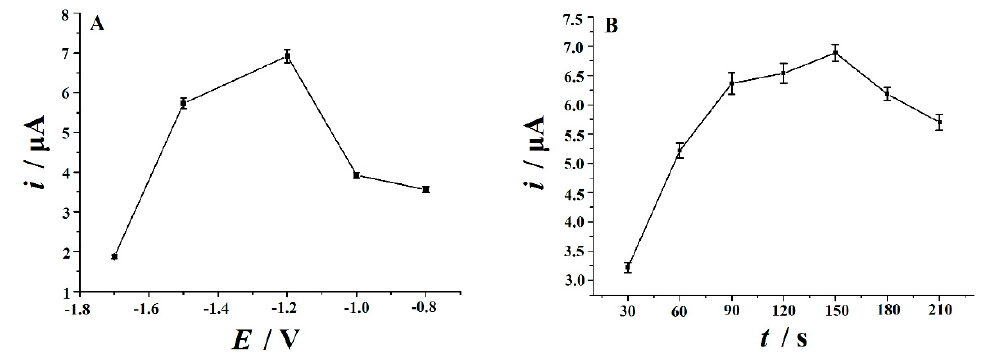
Figure 8. ( A ) Effect of reduction potential and ( B ) reduction time on the peak current of 10 µM rutin in 0.2 M H 2 SO 4 at NH 2 -Fe 3 O 4 NPs-ErGO/GCE by second derivative linear sweep voltammetry (SDLSV). Other conditions are the same as in Figure 7.